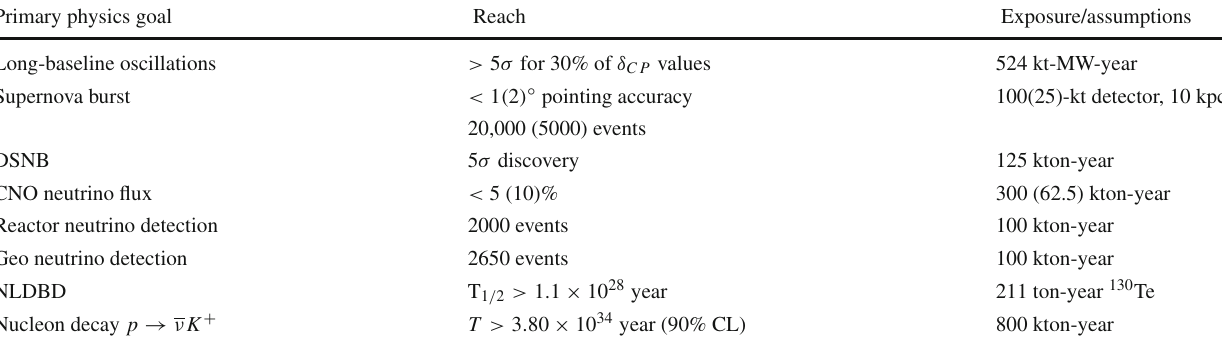
Table 1 Theia physics reach. Exposure is listed in terms of the fiducial volume assumed for each analysis. For NLDBD the target mass assumed is the mass of the candidate isotope within the fiducial volume Primary physics